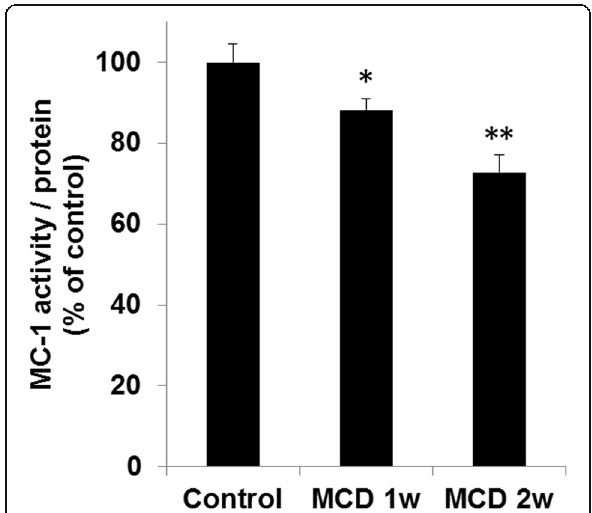
Fig. 3 Hepatic mitochondrial complex-1 (MC-1) activities in mice fed a control or methionine- and choline-deficient (MCD) diet. Data are expressed as the mean ± SEM, n = 6 – 7 mice per group. Statistical differences were assessed using Dunnett ’ s test. * p < 0.05 and ** p